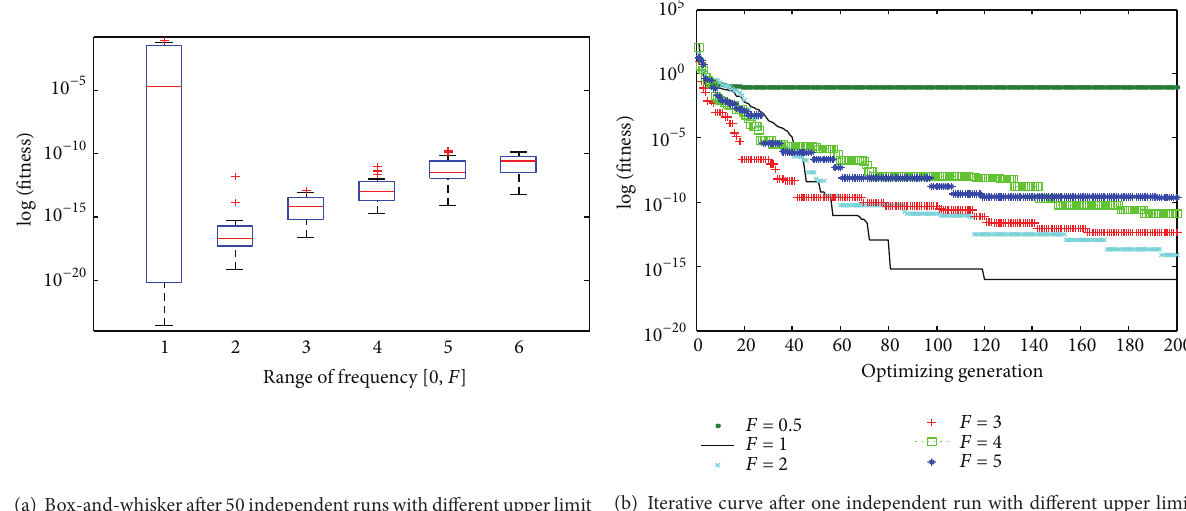
(b) Iterative curve after one independent run with different upper limit of frequency 𝑓 ∈ [0,𝐹] , where 1–6 in abscissa axis correspond to 𝐹 = 0.5,1,2,...5 , respectively Figure 4: Box-and-whisker diagram and iterative curve about the impact of different upper limit of frequency 𝑓 ∈ [0,𝐹] .